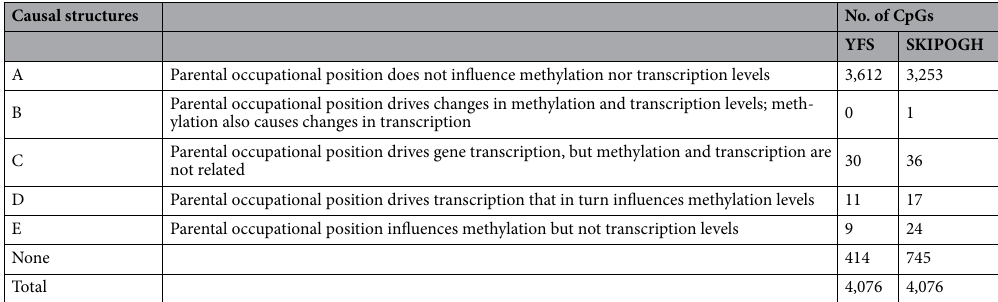
Table 2. Cardinality of the most likely group of model structures across the five tested competing groups (see Figure S5) for a total of 4076 CpG sites in up to N = 1367 YFS and N = 661 SKIPOGH participants. The most likely group of causal structures is selected when its posterior probability is at least roughly three times larger than any other group’s posterior probability. None corresponds to CpGs for which none of the five tested groups reached winning evidence or models could not be estimated as the transcription level was not available in a few genes (37 and 33 CpGs in YFS and SKIPOGH,